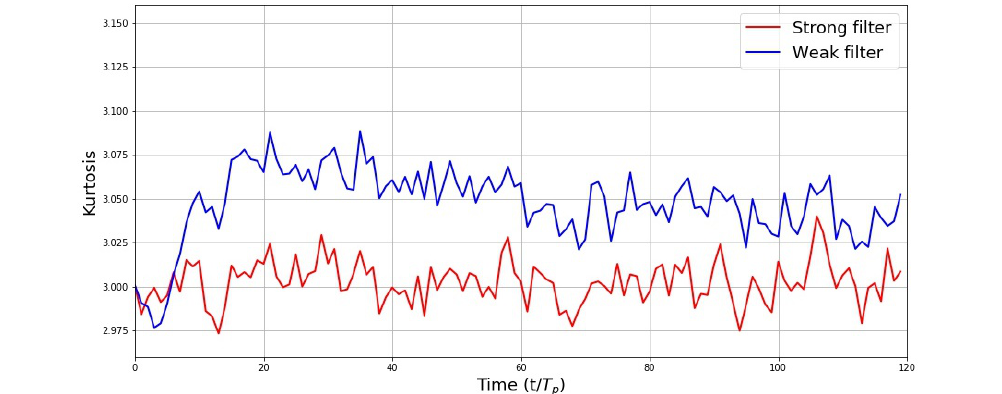
Figure 8. Time evolution of kurtosis for the sea state of 1 March 2017, Ireland, with the use of both the strong and weak energy filters. Time is normalized by the peak wave period T p of the spectrum. The statistical parameters are estimated from an ensemble of 20 HOS simulations.